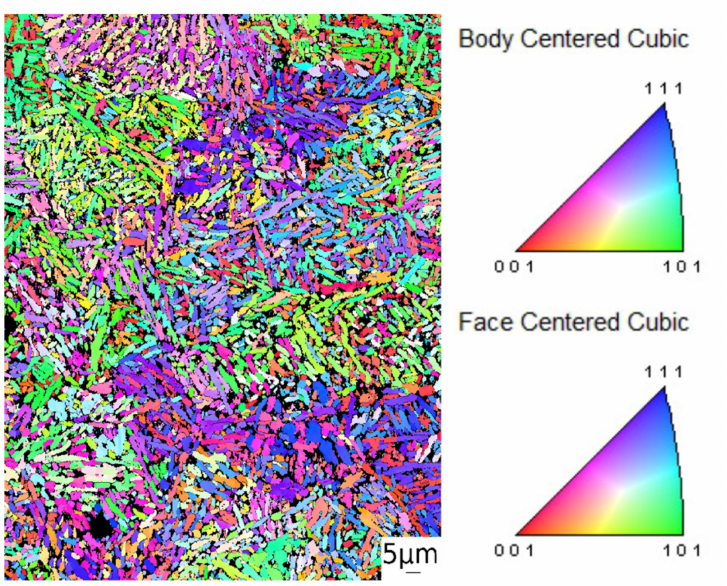
Figure 11. Electron Backscattered di ff raction (EBSD) micrograph and related inverse pole figure of the austempered sample.